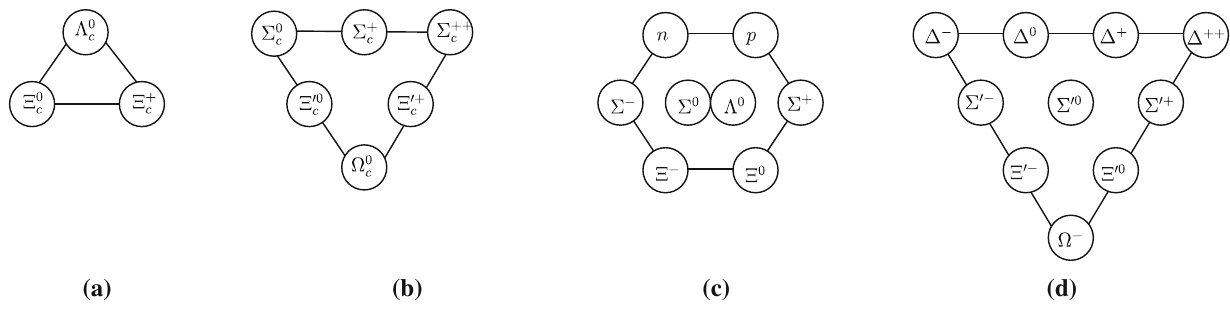
Fig. 2 The weight diagrams for the singly charmed baryons are given in ( a , b ), which triplet T multiplets are T 8 , T 10 shown in ( c , d ) respectively